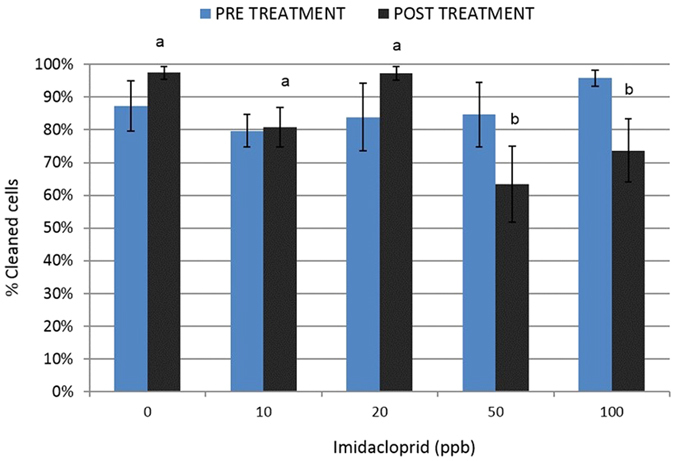
Hygienic behavior assays or percent (SE) of freeze-killed brood removed in 24 hours by worker honey bees from “7000-bee” colonies before and after chronic imidacloprid exposure (dose: F4, 18 = 4.5; p = 0.01).Different letters denotes significant statistical differences at α < 0.05 among treatment levels for post treatments only (no significant differences found in pre-treatment assay (F4,18 = 0.3; p = 0.9). Results indicate significantly lower hygienic behavior in higher treatments (50 & 100 ppb) only. Hygienic behavior was used as a measure to assess worker activity inside the hive, and is defined as the ability of worker bees to detect and remove diseased and mite-infested brood thereby limiting within-colony transmission of pathogens and parasites.